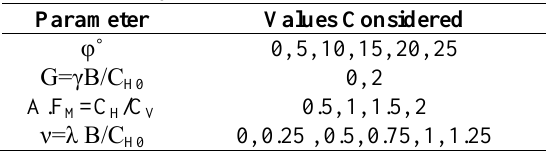
Table 2. Parameters in deterministic bearing capacity analysis of shallow foundation.